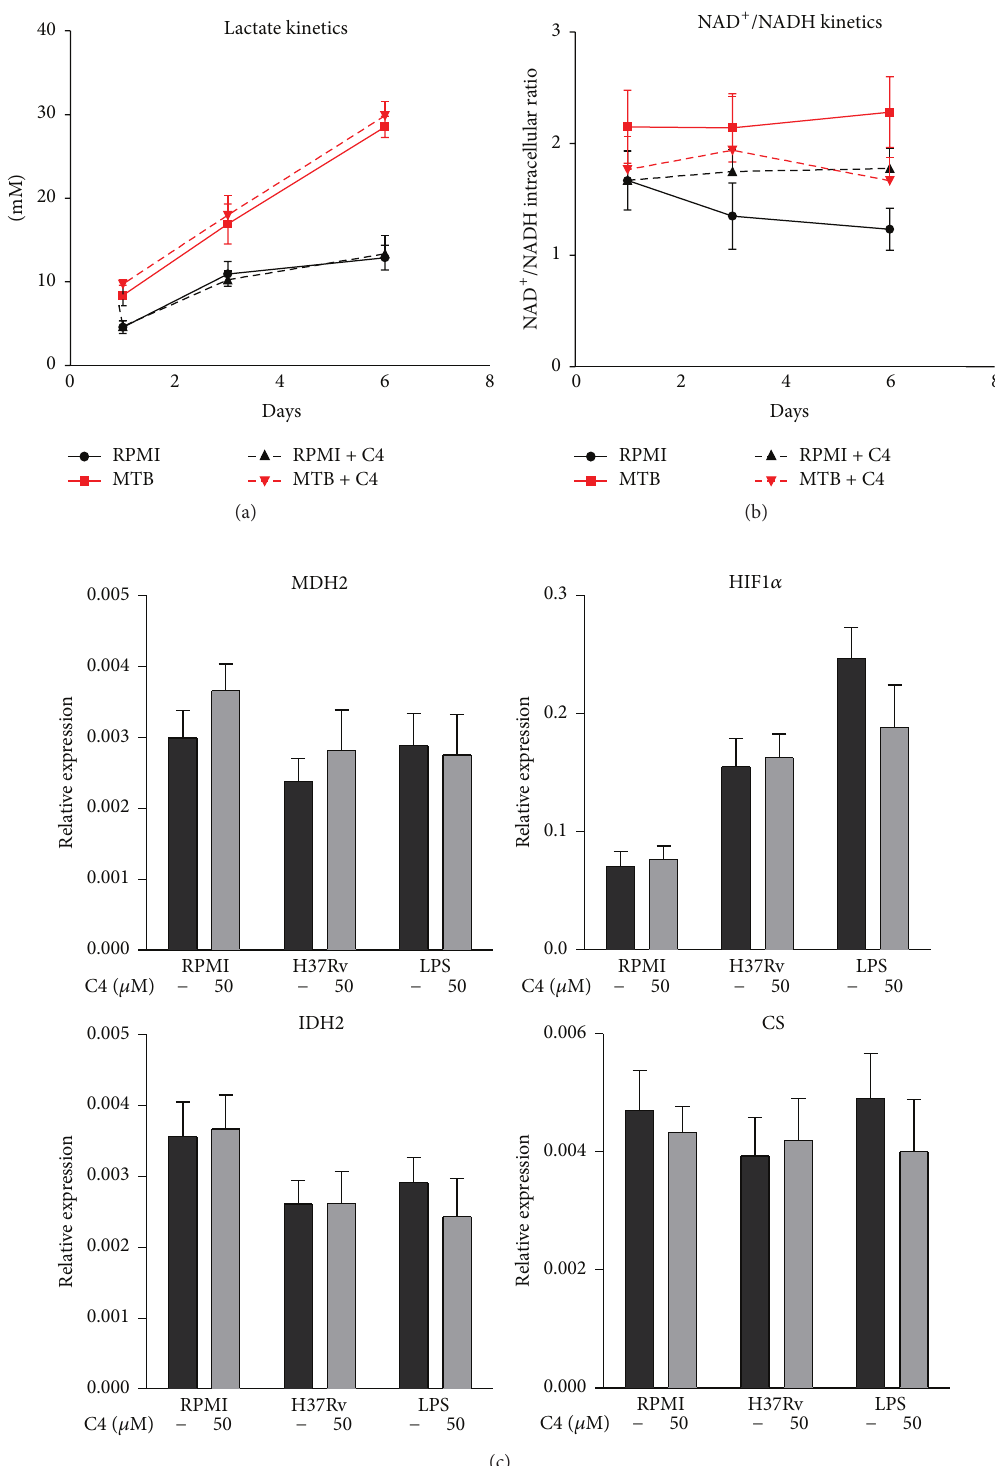
Figure 4: Influence of butyrate on cellular metabolism. (a and b) Kinetics of lactate production (a) and intracellular NAD + /NADH ratios (b) from days 1, 3, and 7 of PBMCs preincubated with 50 𝜇 M C4 (1h) with and without stimulation with Mtb lysate. Data are means ± SEM ( 𝑛 = 3 to 5), using Wilcoxon signed-rank test, representative of 1-2 independent experiments. (c) Expression levels of glycolysis and TCA cycle genes in PBMCs preincubated with 50 𝜇 M C4 (1h) and stimulated with Mtb lysate or LPS (4h) as measured by qPCR. Data are means ± SEM ( 𝑛 = 6 ), using Wilcoxon signed-rank test, representative of 2 independent